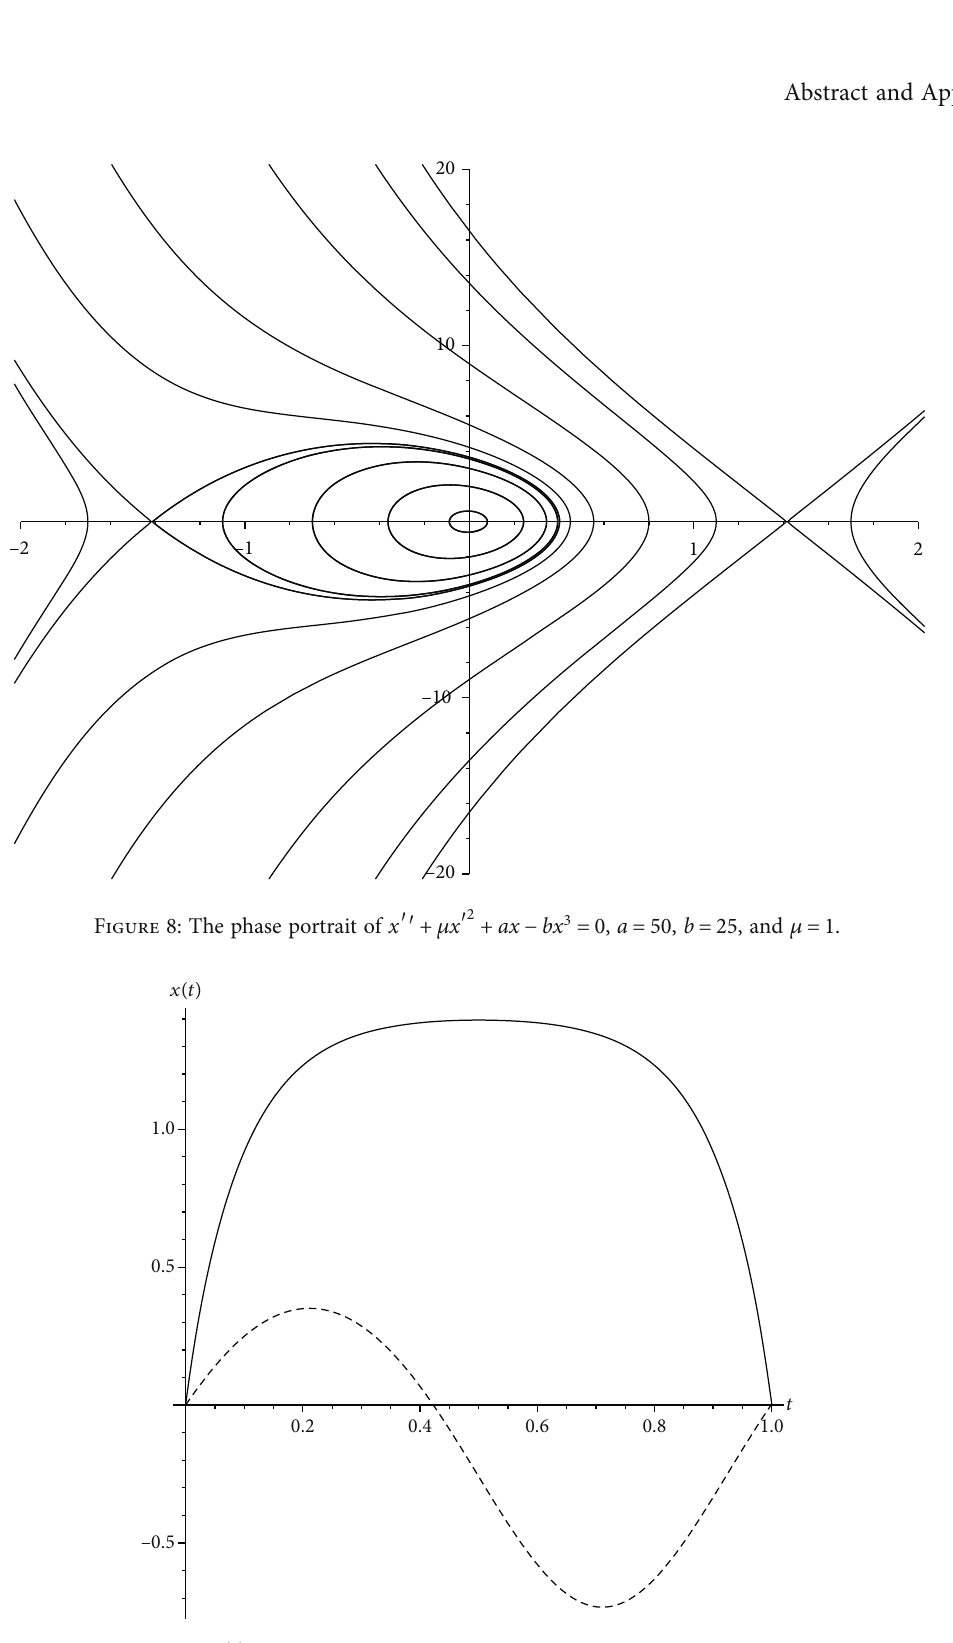
Figure 9: Graphs x ð t Þ for solutions of problems (30) and (31), α ≈ 16 : 4802 , α ≈ 3 : 1